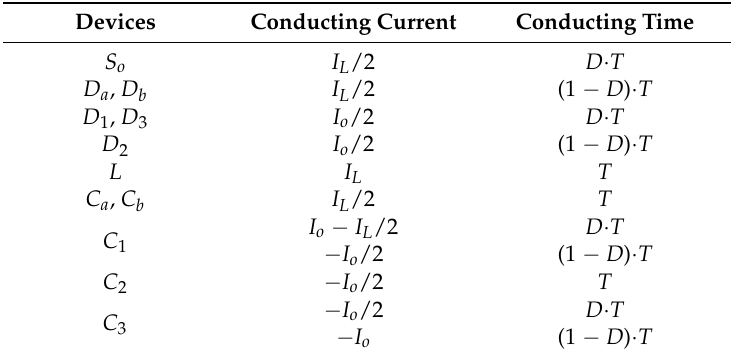
Table 1. Conducting current of the devices in the proposed SC